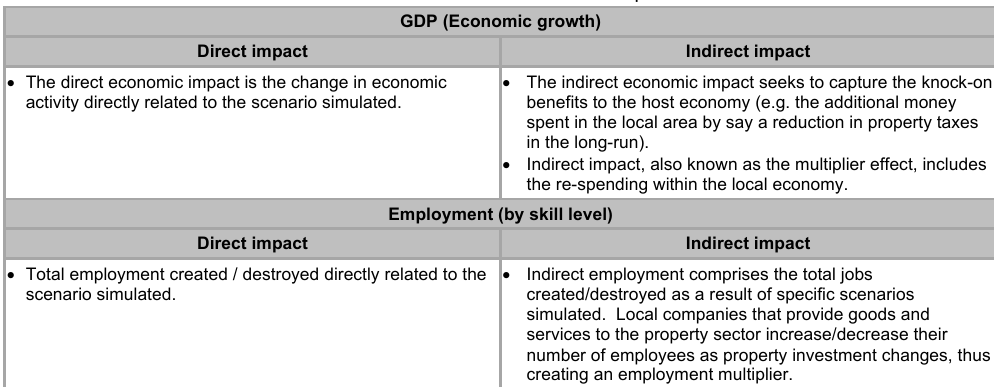
Definitions of direct and indirect